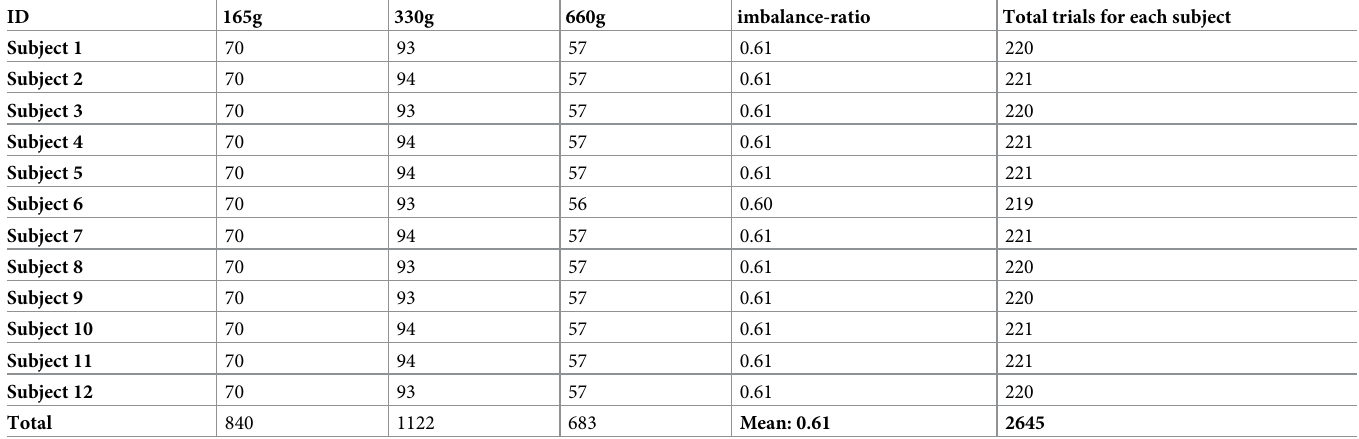
Table 1. The number of trials for each class and each